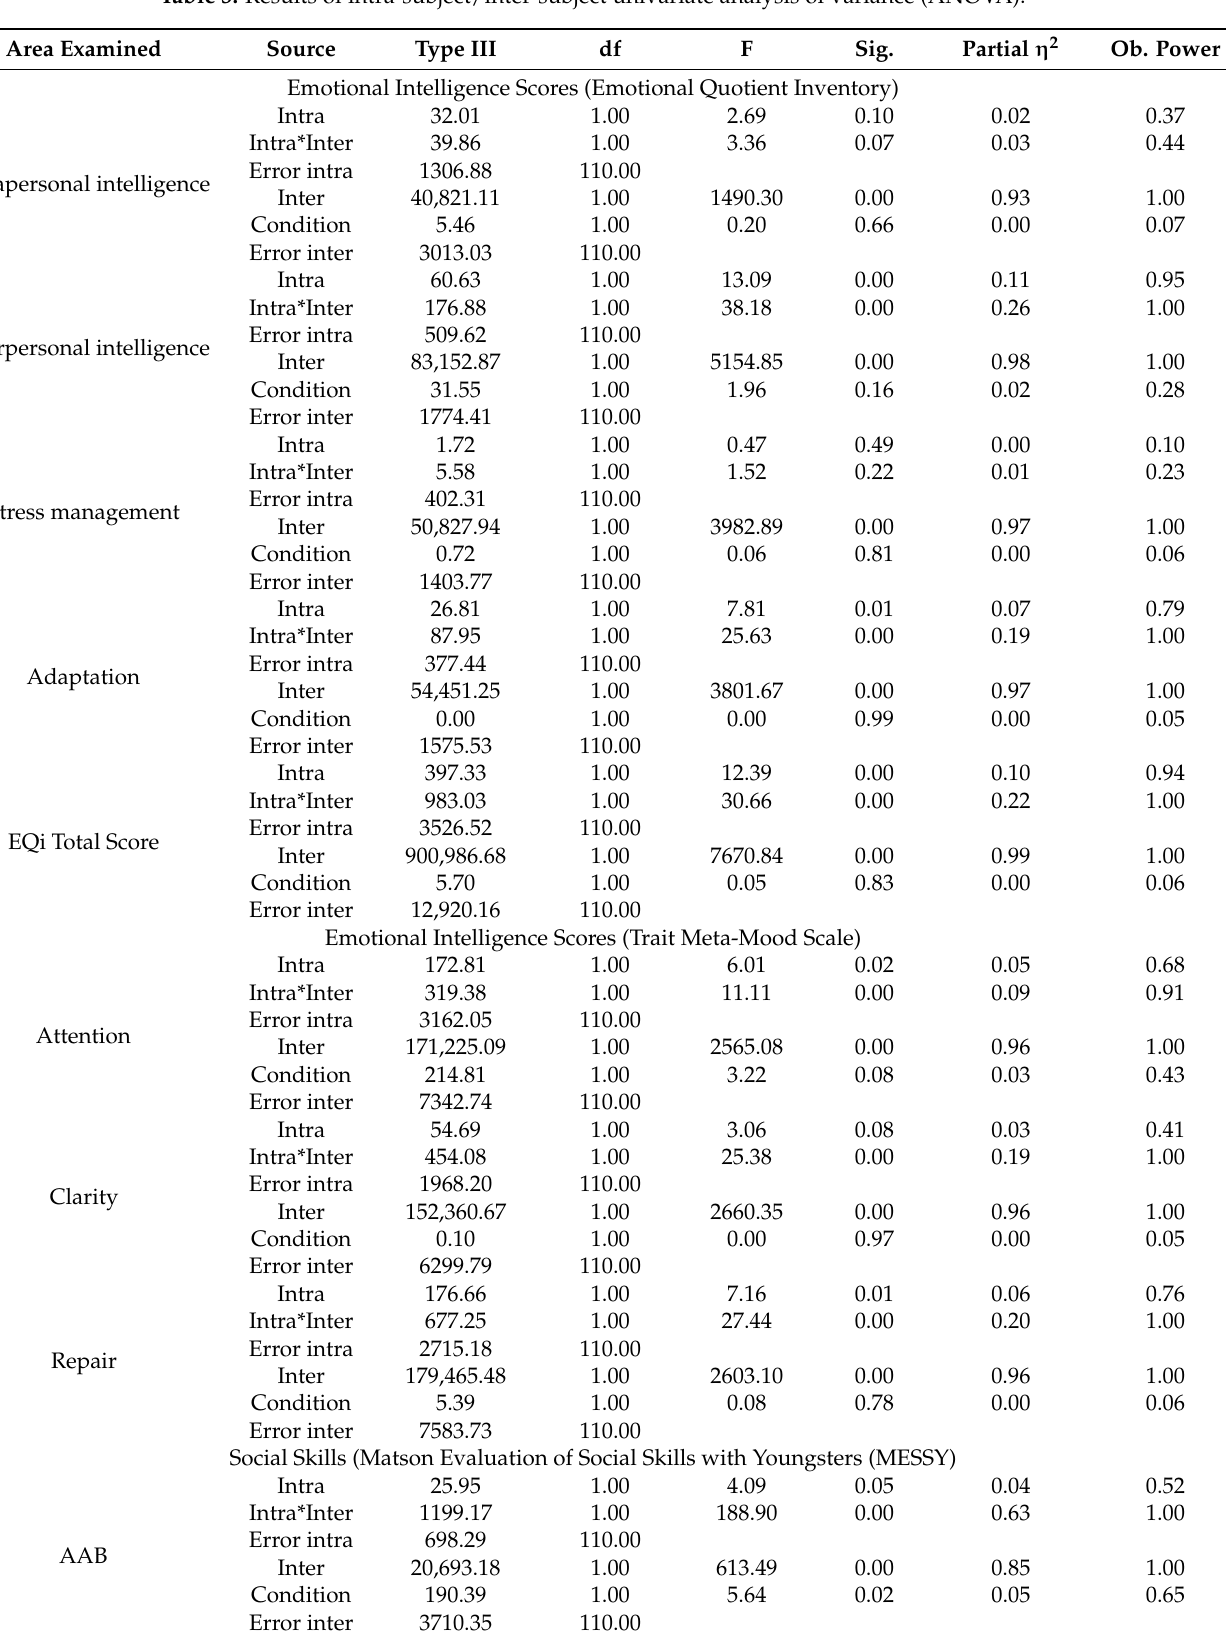
Table 3. Results of intra-subject/inter-subject univariate analysis of variance (ANOVA). Area